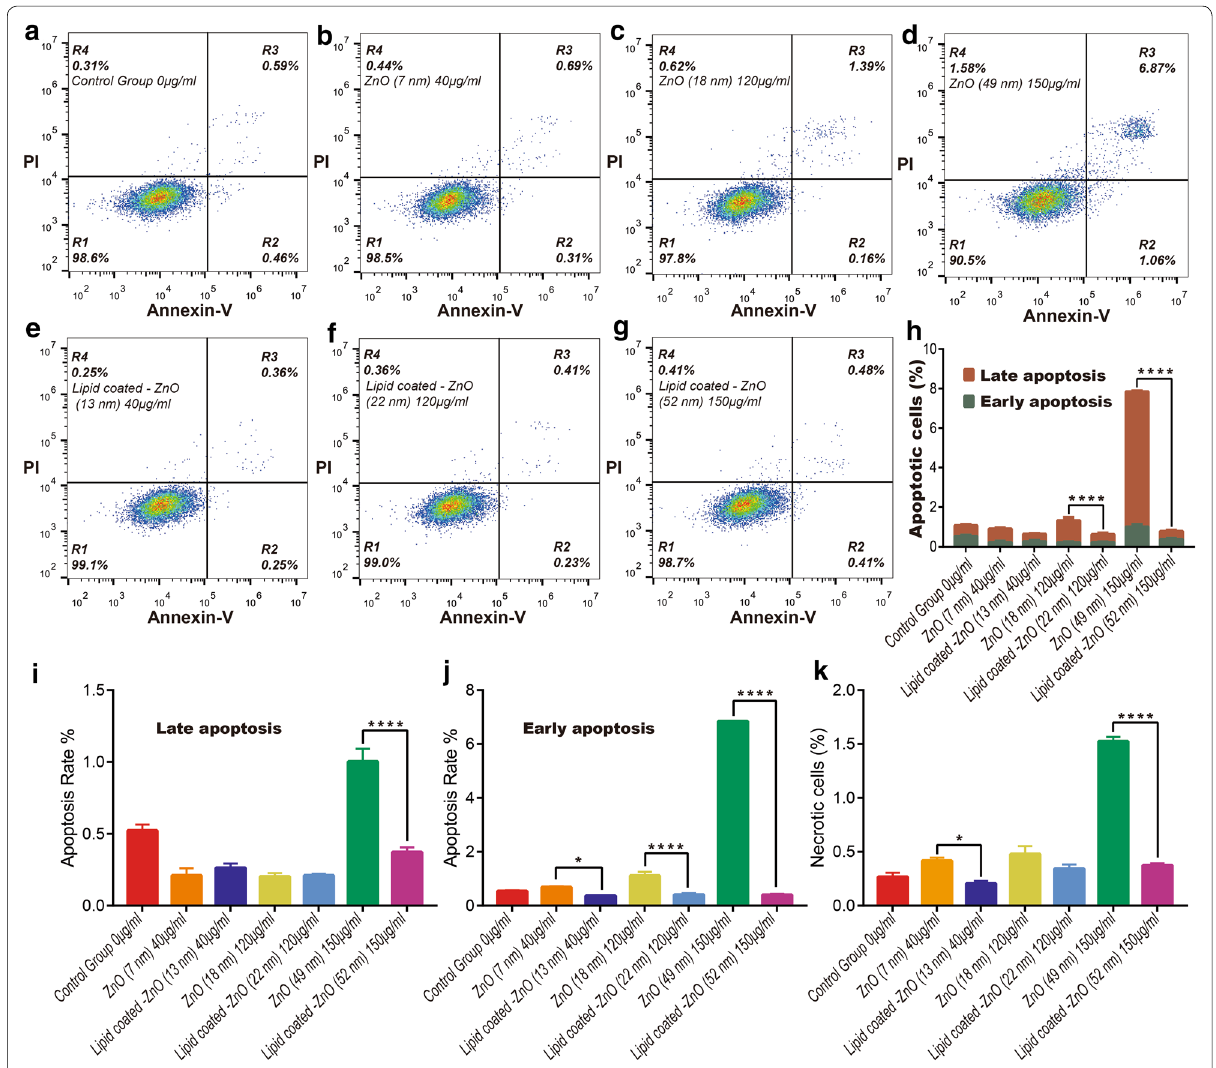
Fig. 10 The apoptosis and necrosis of HeLa cells after 24-h of the exposure of ZnO NPs and lipid-coated ZnO NPs as detected by flow cytometry. a – g The representative flow cytometer images of HeLa cells after being exposed to pristine ZnO NPs (~ 7 nm; ~ 18 nm; ~ 49 nm) and lipid-coated ZnO NPs (~ 13 nm; ~ 22 nm; ~ 52 nm) for 24 h (0, 40, 120 and 150 μg/mL). h – k The quantitative results of apoptotic and necrotic percentages from flow cytometry analysis. *p < 0.05, **p < 0.01, ***p < 0.001, ****p <